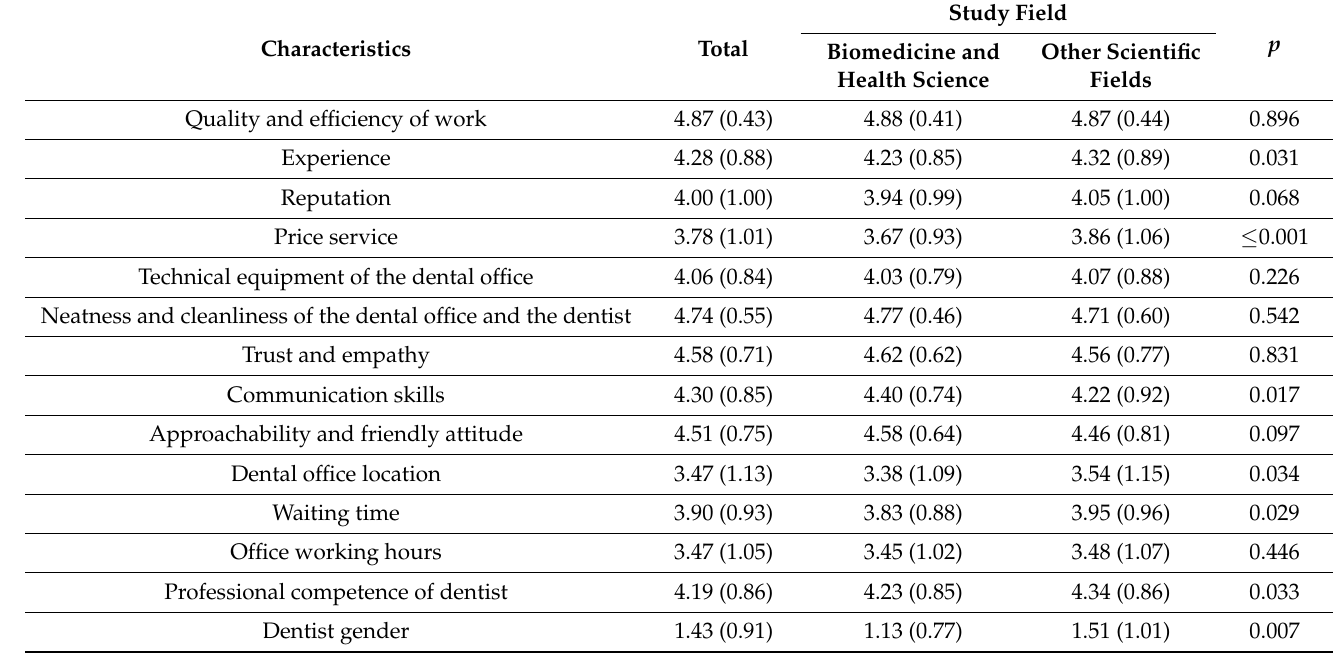
Table 5. Evaluation of the most important reason for choosing a dentist.